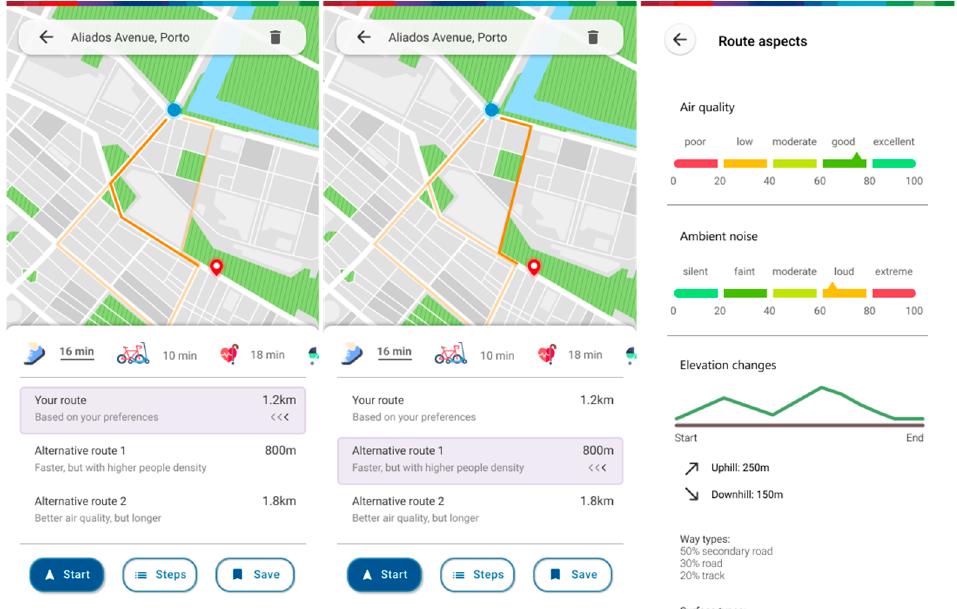
Figure 11. Navigation screens featuring a preferred route, choice of an alternative route, and further information regarding route aspects of a certain route.